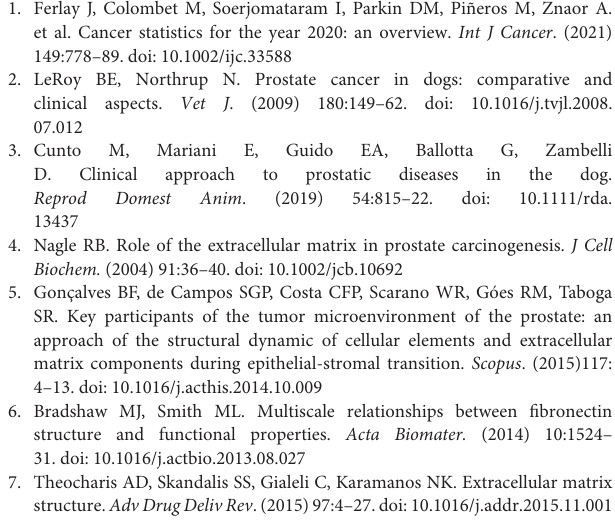
Supplementary Table 1 | | Complete list of differentially expressed genes in LNCaP and PC-3 cells. Supplementary Table 2 | | STRING Interactions in LNCaP and PC-3